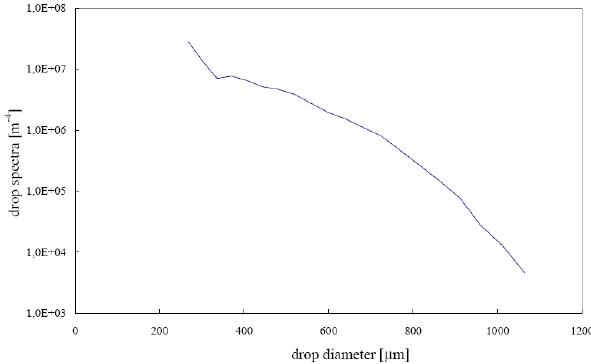
840 Figure 13. Particle size spectrum as obtained from the rain radar. 841 Fig. 13. Particle size spectrum as obtained from the rain radar.